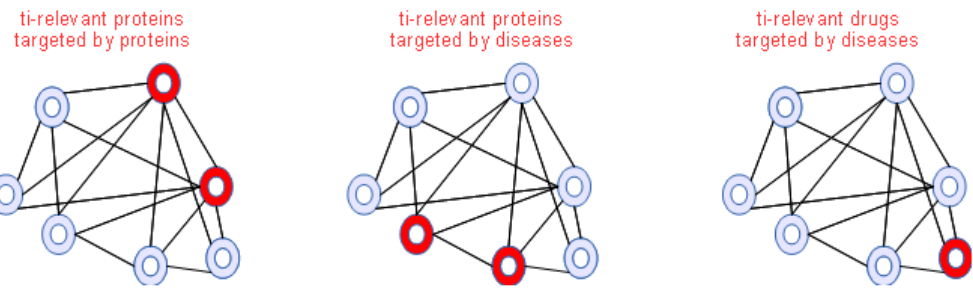
Figure 6. Time relevance variation after combining different type of source and target entity.